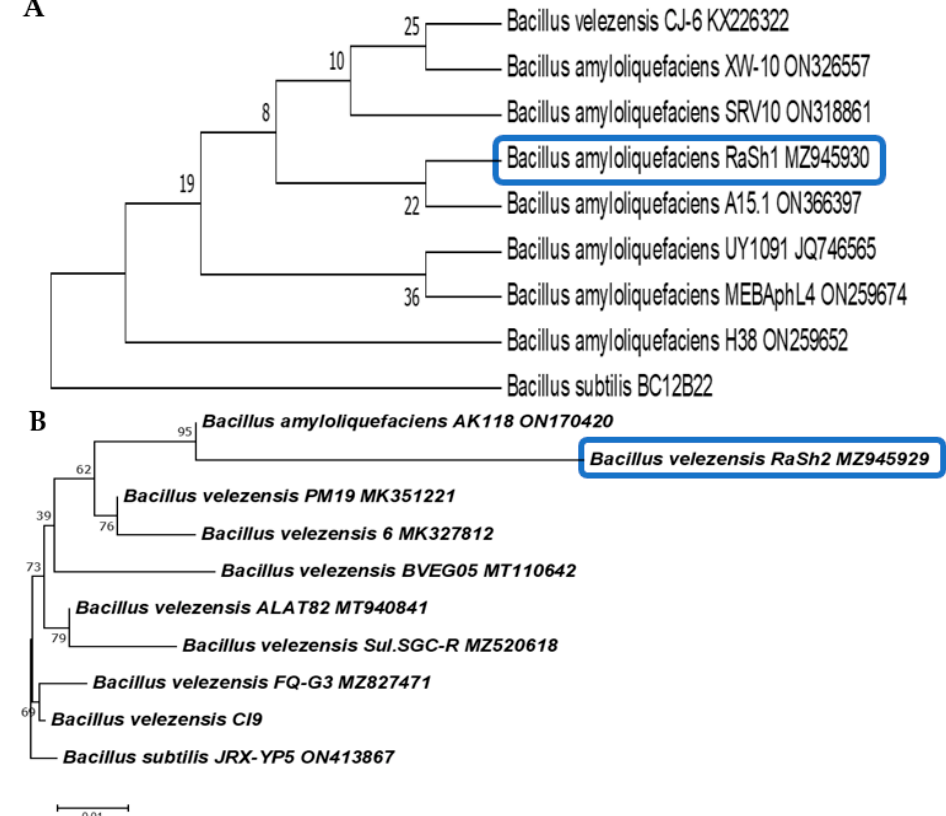
Figure 4. Phylogenetic analysis of B. amyloliquefaciens RaSh1 (MZ945930) ( A ), and B. velezensis RaSh2 (MZ945929) ( B ), showing their relationship with the ITS sequences of closely related Bacillus strains retrieved from the NCBI GenBank database. The percentage of replicate trees in which the associated taxa clustered together in the bootstrap test (1000 replicates) is shown next to the respective branches. The evolutionary distances were computed using the Maximum Composite Likelihood method and are in the units of the number of base substitutions per site. Evolutionary analyses were conducted in MEGA7 program. Bacillus subtilis BC12B22 is used as an outgroup for B. amyloliquefaciens RaSh1, and Bacillus subtilis JRX ‐ YP5 ON413867 is used as an outgroup for B. velezensis RaSh2.